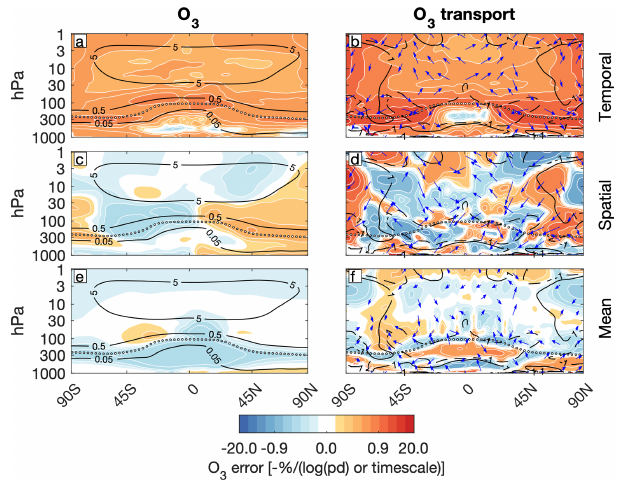
Figure 14. Negative of the projection of (a, b) root-mean-square temporal error, (middle row) root-mean-square spatial error, and (e, f) mean error in ( a, c, e , shading) the ozone mole fraction and ( b, d, f , vectors) the combined TEM residual circulation and eddy ozone flux and (shading) convergence onto the (a, b) logarithm of meteo- rology frequency and (c, d, e, f) nudging timescale. Climatology in contours in (a, c, e) parts per thousand and (b, d, f) percent per day, with negative values dashed. The tropopause is shown by the black and white dotted contour.